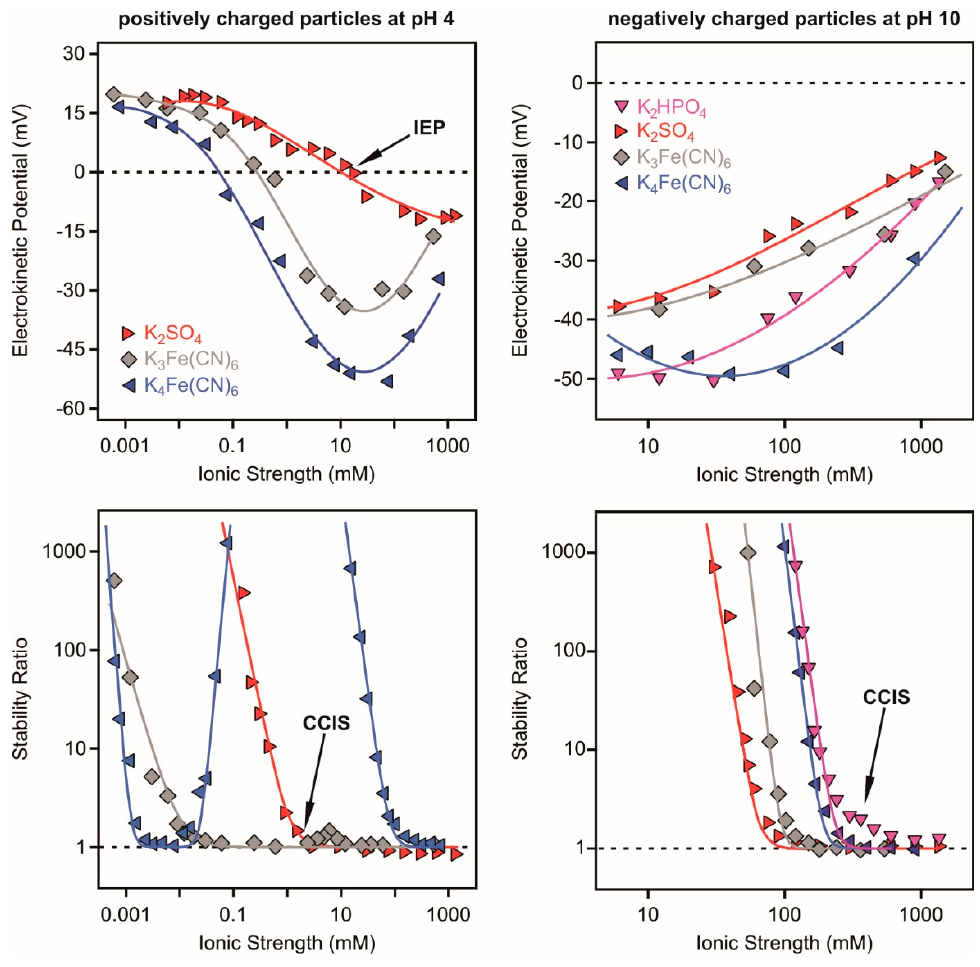
Figure 4. Electrokinetic potentials ( top row ) and stability ratios ( bottom row ) of titania nanosheets as a function of the ionic strength set by different multivalent electrolytes below the PZC at pH 4 ( left column ) and above the PZC at pH 10 ( right column ), where the nanosheets were positively or negatively charged, respectively. The concentration of the particles was kept constant at 1 mg/L. Reprinted with permission from Reference [59]. Copyright (2017) American Chemical Society.